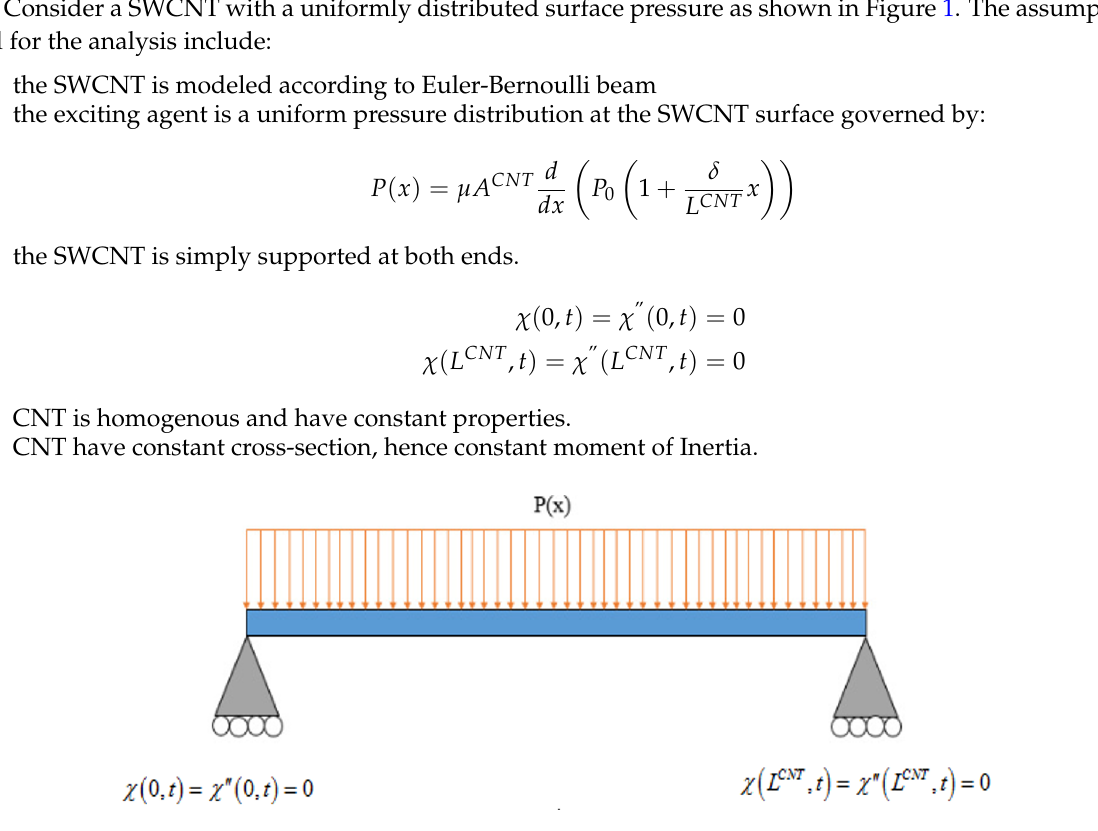
Figure 1. Schematic of the SWCNT with Static and Moving uniformly distributed pressure at the